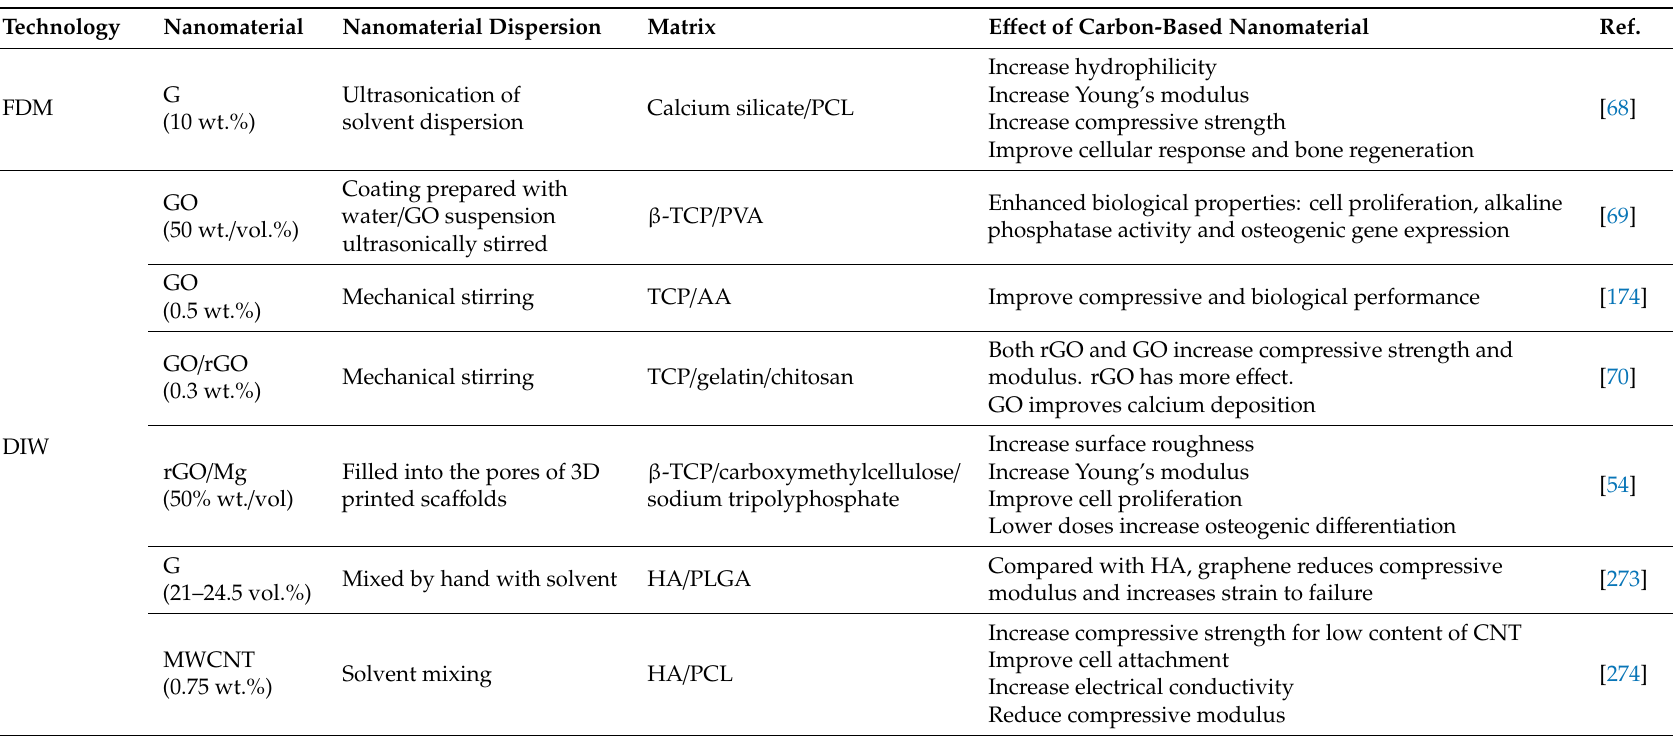
Table 4. Ceramic-based 3D sca ff olds fabricated by using additive manufacturing (AM) techniques with di ff erent carbon-based nanomaterials.